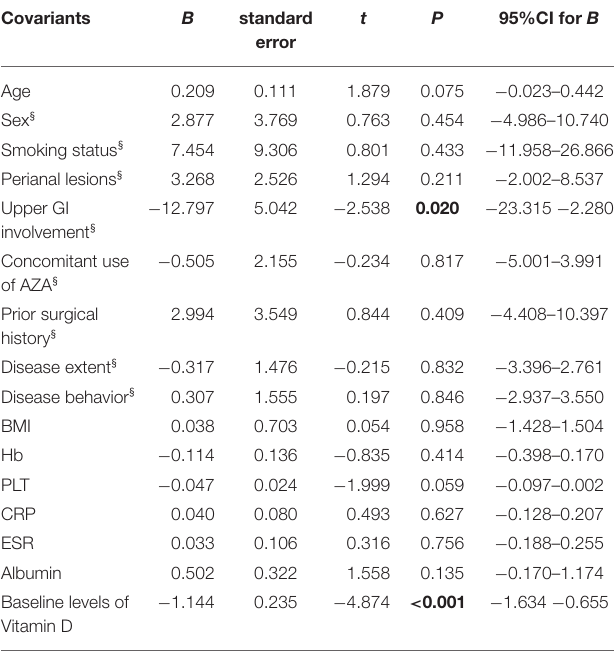
TABLE 2 | Influence factors on the increase of vitamin D levels in CD patients supplemented by vitamin D3 (Liner regression, enter) ( n = 37). t P 95%CI for B Serum calcium and phosphorus levels at baseline and Covariants B standard error